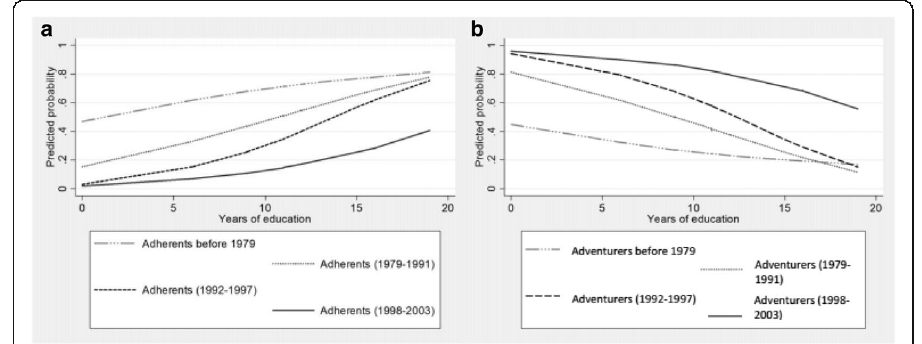
Fig. 3 a , b Predicted probabilities of adherents and adventurers by education and job entry era — X-axis measures education by years, and Y-axis measures probabilities (between 0 and 1); the long-dash-dot-dot- dot line indicates the period before 1979, the dotted line indicates the period between 1979 and 1991, the short-dash line indicates the period between 1992 and 1997, and the solid line indicates the period between 1998 and 2003. a The predicted probability of being adherents in four periods. b The predicted probability of being adventurers in four